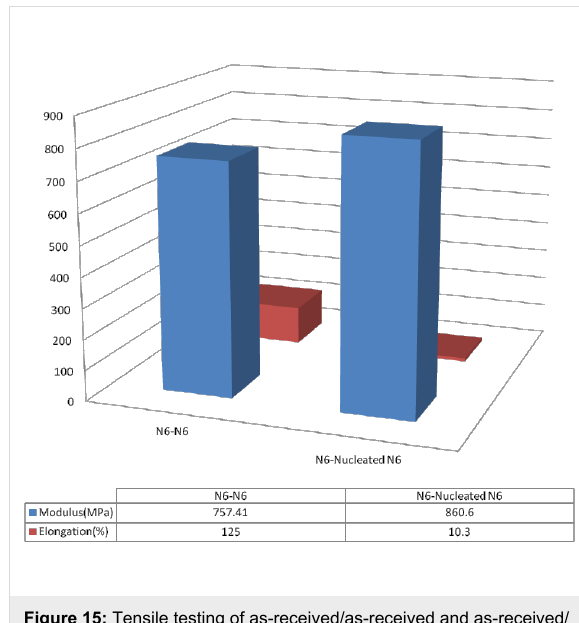
Figure 15: Tensile testing of as-received/as-received and as-received/ nucleated nylon-6 film sandwiches conducted according to